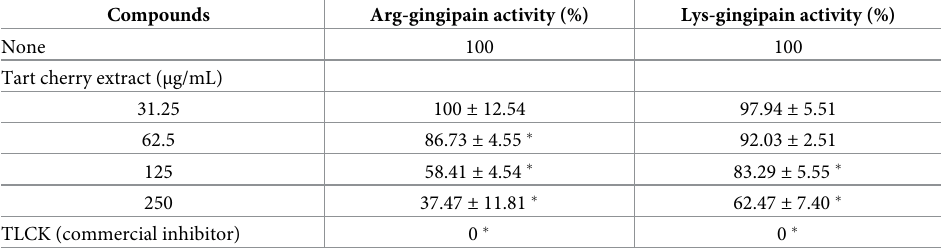
Table 2. Effect of the tart cherry extract on the Arg- and Lys-gingipain activities of P . gingivalis